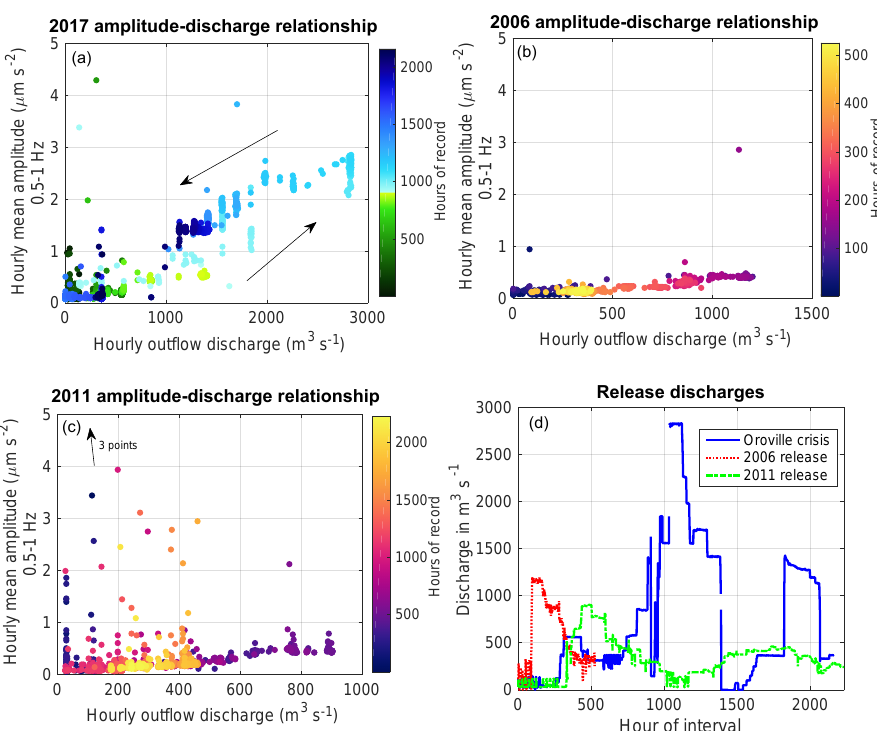
Figure 5. The plot of mean hourly amplitude of the dominant eigenvector in the 0.5–1Hz frequency band vs. hourly discharge shows that the two correlate strongly. The abrupt change in the color bar coincides with the timing of the Oroville Dam crisis, and allows two distinct regimes to be identified. Seismic amplitudes are greater by ∼ 0.5µms − 2 after the uncontrolled channel erosion begins on 7 February, and remains greater even as discharge decreases to earlier levels, demonstrating that hysteresis is observed. This hysteresis is greatest in the 0.5–1Hz frequency band. Note the changing x axis range in panels (a) through (c) .